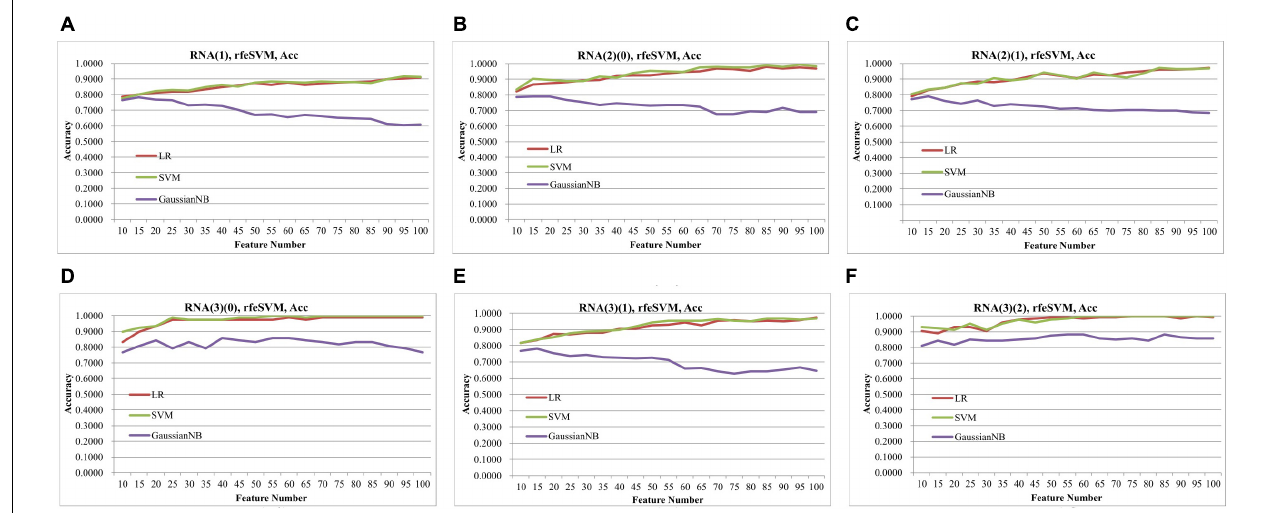
FIGURE 2 | Classification performances of rfeSVM screening of top-ranked 1000 features by T -test. The accuracy was calculated by the 10-fold cross validation of three classifiers, i.e., LR, SVM, GaussianNBayes. The horizontal axis was the number of features screened by rfeSVM, and the vertical axis was accuracy. The plots were for the datasets (A) RNA(1), (B) RNA(2)(0), (C) RNA(2)(1), (D) RNA(3)(0), (E) RNA(3)(1), and (F) RNA(3)(2). TABLE 2 | The number of times each classifier achieved the best accuracy for the RFE-screened features of a given dataset. rfeSVM